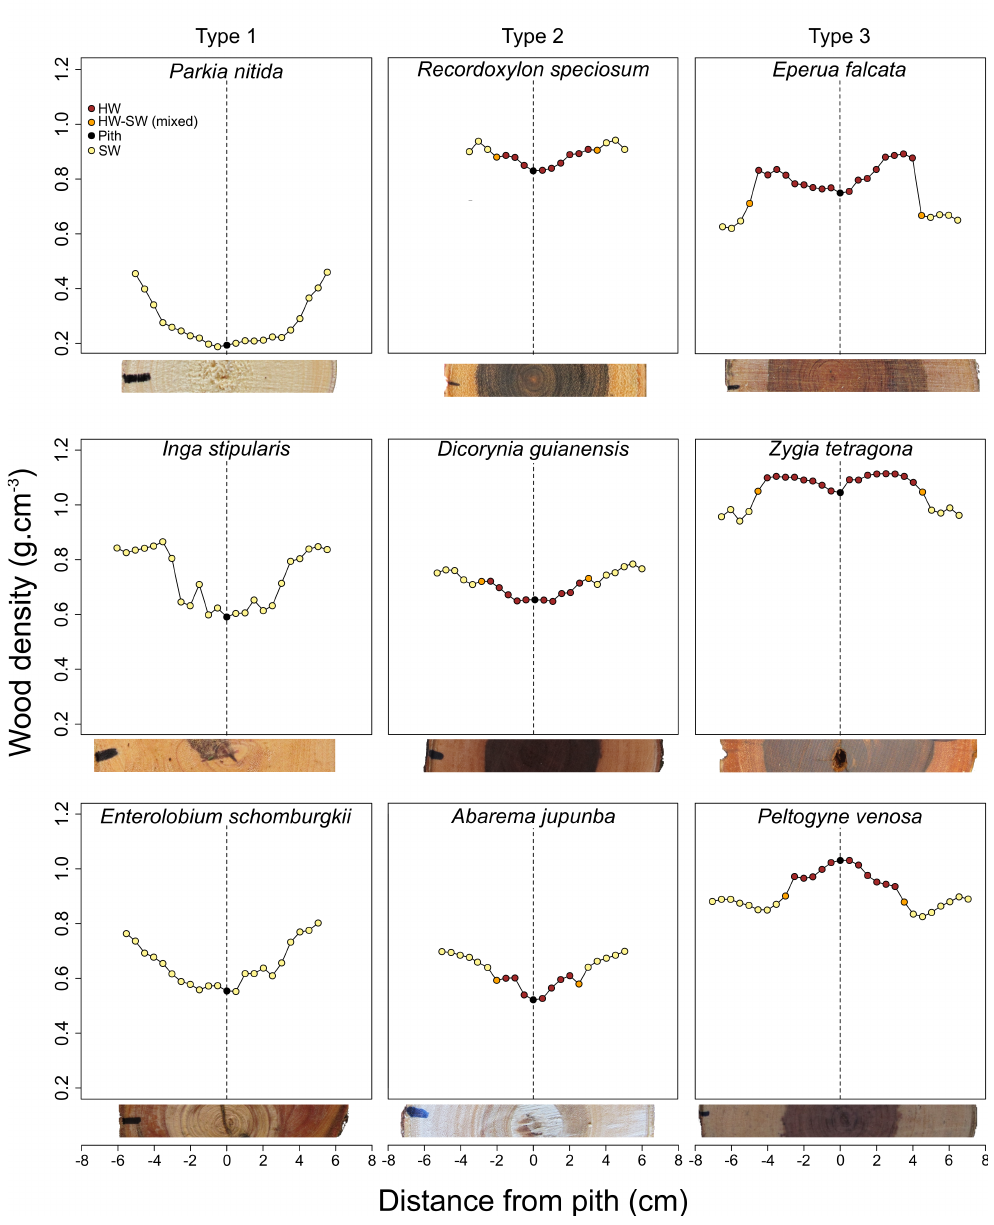
Figure 3. Diversity of radial patterns of WD variations and the effect of heartwood. Wood density is plotted according to distance from the pith for 9 species sampled. Each column refers to a qualitative type of radial pattern (Type 1, HW-free species and increasing WD; Type 2, HW species and increasing WD; and Type 3, HW species and decreasing WD). Pith, sapwood, sapwood-heartwood, and heartwood samples are indicated with black, yellow, orange, and brown symbols, respectively. The vertical dotted lines indicate the center of each stem (i.e., the pith). Pictures displayed below each plot show the diametric sample considered and the absence/presence of